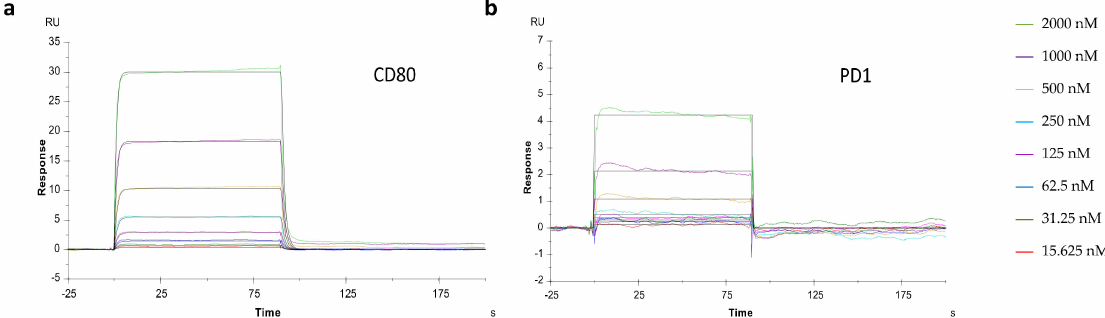
Figure 2. Representative sensorgrams of CD80 ( a ) and PD1 ( b ) binding to HYBRI. HYBRI was bound to CM5 chip and CD80 and PD1 serial dilutions (15.625, 31.25, 62.5, 125, 250, 500, 1000, and 2000 nM) represented in distinct colors were injected for 90 s. Experimental data are shown as color traces and black traces represent the fitted data according to the 1:1 Langmuir binding